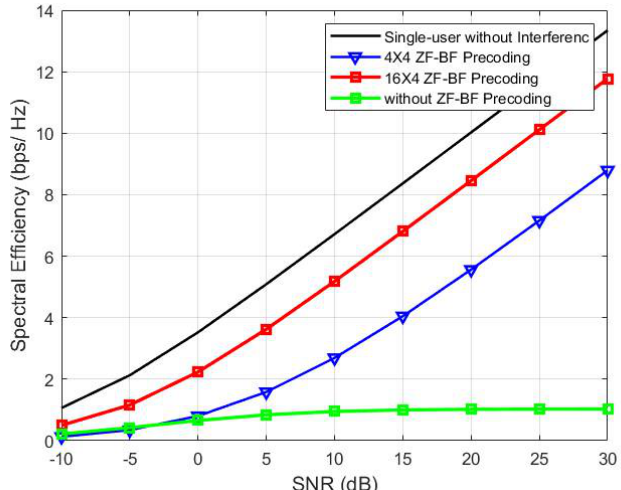
Figure 8. Comparison among ZF-BF precoding: Achievable rate varying SNR in the range SNR [−10; 30] dB with number of antennas 16 and number of users 4.